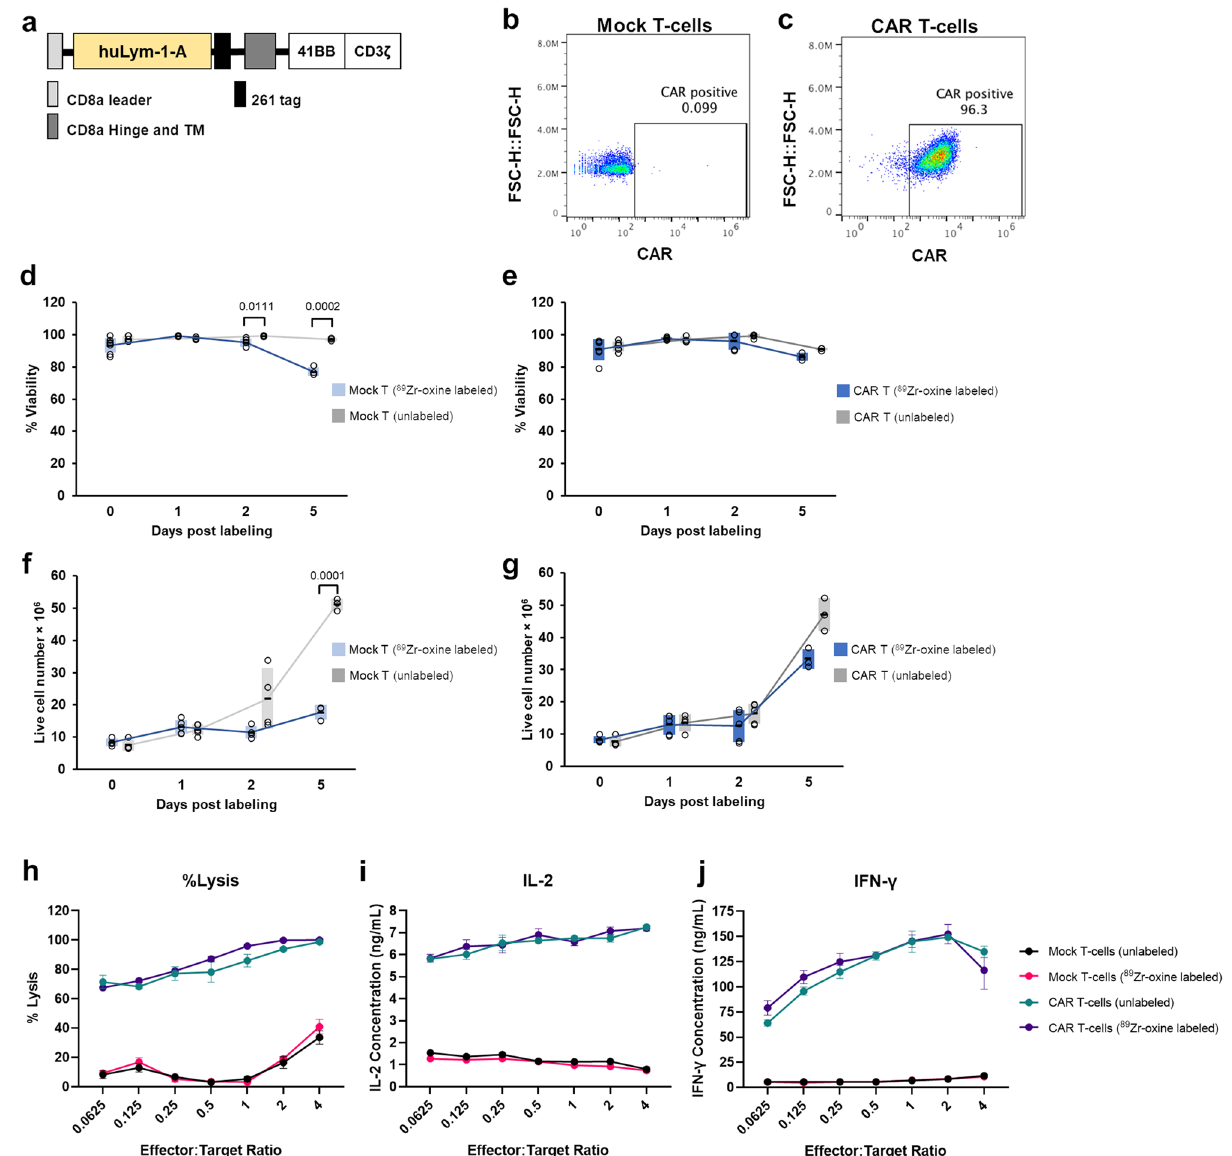
Figure 2. 89 Zr-oxine labeling does not significantly alter cell health and function of huLym-1-A-BB3z-CAR T-cells. ( a ) Schematic of 2nd generation CAR construct used for huLym-1-A-BB3z-CAR T-cells. Adapted from Zheng, et al., 2020 with permission of the copyright owner. ( b , c ) Flow cytometry analysis of CAR expression on non-transduced (mock) or transduced primary human T-cells (huLym-1-A-BB3z-CAR T-cells) on day 7. CAR expression was measured using Dylight 650-conjugated antibody against the 261 tag. ( d , e ) Percent viability measurement of subcultured 89 Zr-oxine labeled and unlabeled mock and huLym-1-A-BB3z-CAR T-cells on day 0, 1, 2, and 4 time points, which correspond to 3, 24, 48, 120 h after 89 Zr-oxine labeling, respectively. ( f , g ) Total live cell count (× 10 6 ) of subcultured 89 Zr-oxine labeled and unlabeled mock and CAR T-cells on the same time points. Viability and live cell number plots show dash lines as means, colored bars as standard deviation ranges, and open circles as individual data points. Significant differences are shown with p-values above brackets. A value of p < 0.05 was used to indicate statistical significance. ( h ) Cytotoxicity of 89 Zr-oxine labeled and unlabeled mock and huLym-1-A-BB3z-CAR T-cells against Lym-1-positive Raji cells. ( i , j ) IL-2 and IFN-γ cytokines released by 89 Zr-oxine labeled and unlabeled mock and huLym-1-A-BB3z-CAR T-cells. Cytotoxicity and cytokine release plots show means (closed circles) and standard deviation error bars. Labeling with 89 Zr-oxine show unaltered CAR T-cell cytotoxicity and IL-2 and IFN-γ cytokine